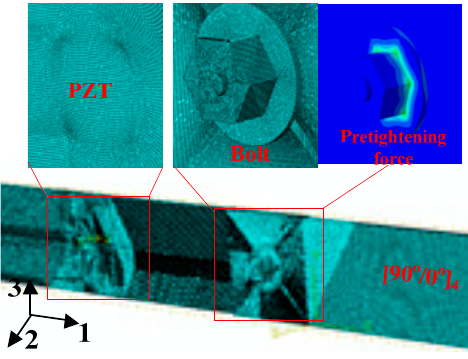
Figure 13. FE model in the Lamb wave inspection simulation with details (Coordinate system: 1: length, 2: thickness and 3: width direction). length, 2: thickness and 3: width